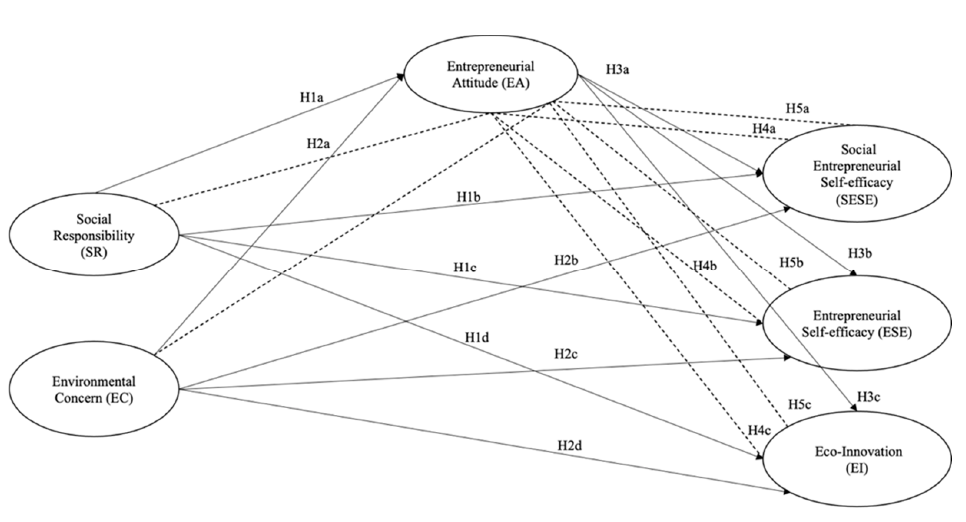
Figure 1. Conceptual model. Note: Dashed lines represent the indirect effects.